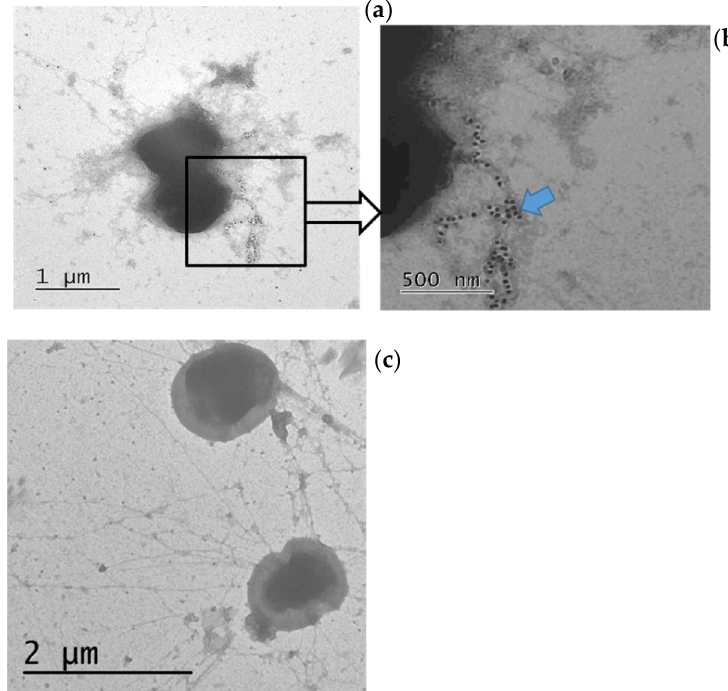
Figure 4. The structure of E. faecium L3 pili with expression of NA. ( a ) Enterococcus with NA expres- sion treated with primary antibodies to NA and secondary gold-conjugated goat anti-human IgG, 60,000 × magnification; ( b ) The pili of Enterococcus with NA expression, 90,000 × magnification; the blue arrow marks gold-conjugated goat anti-human IgG; ( c ) Pure Enterococcus treated with primary antibodies to NA and secondary gold-conjugated goat anti-human IgG, 60,000 ×